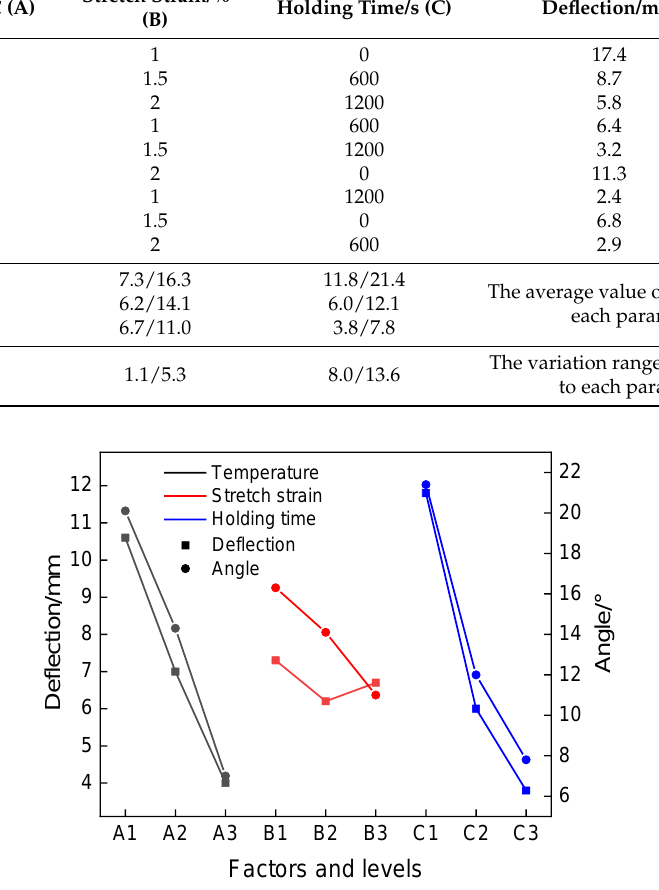
Figure 18. The deflection and angle corresponding to different factors and levels.